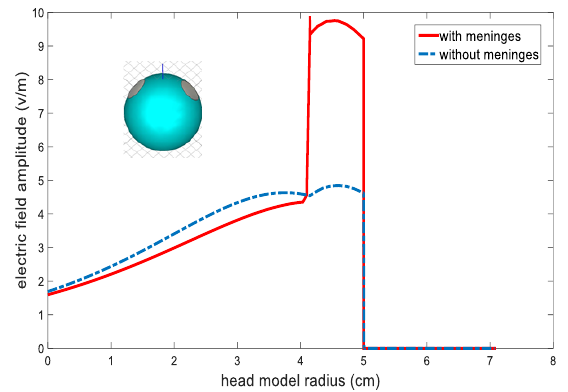
Fig. 5: Electric field in the hypothetical line in the bisector of the electrodes from the center to the skin in the two models.